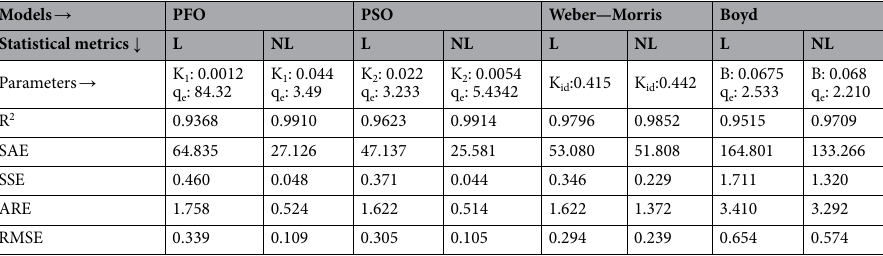
Table 3. Kinetic models for diazinon removal by pumice**. **Linear (L). Non-linear (NL). Pseudo first order (PFO) and Pseudo second-order (PSO). q i e , exp , q i e , pred are the q e values of the experimental and predicted values, respectively. p is the number of parameters. n is the number of experimental runs. Pseudo-first-order model (PFO) & pseudo-second-order model (PSO). Units: q e (mg/g), K 1 (min −1 ), K 2 (g mg −1 min -1 ), K id (mg/g min 0.5 ), Di (cm 2